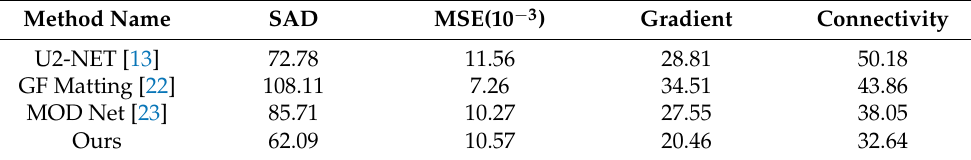
Table 3. Comparison results of several methods on self-built test